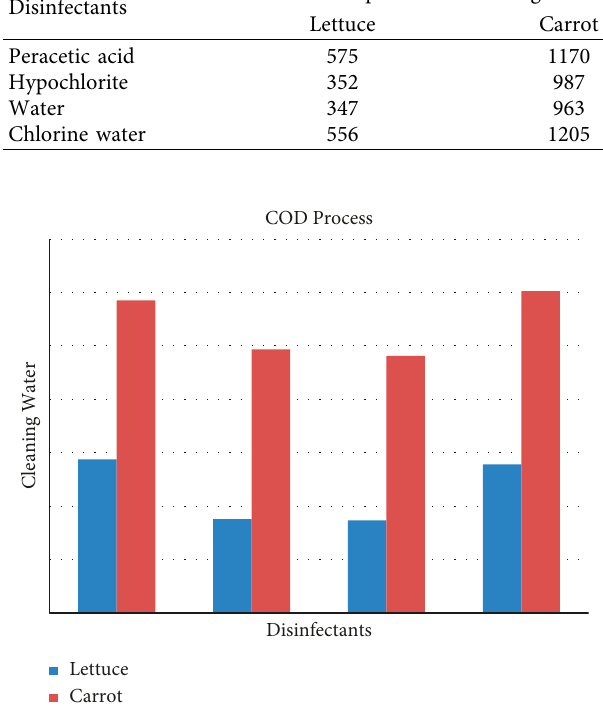
Figure 3: Graphical representation of COD process of vegetables in clean water with